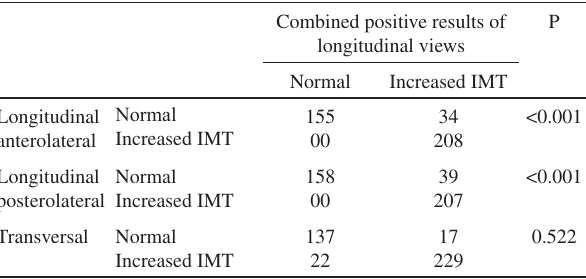
Table 2 - A direct comparison of the accuracy of the com- bined positive results of longitudinal views with the accuracy of the isolated transversal and longitudinal measurement angles– number of common carotid arteries with increased intima-media thickness